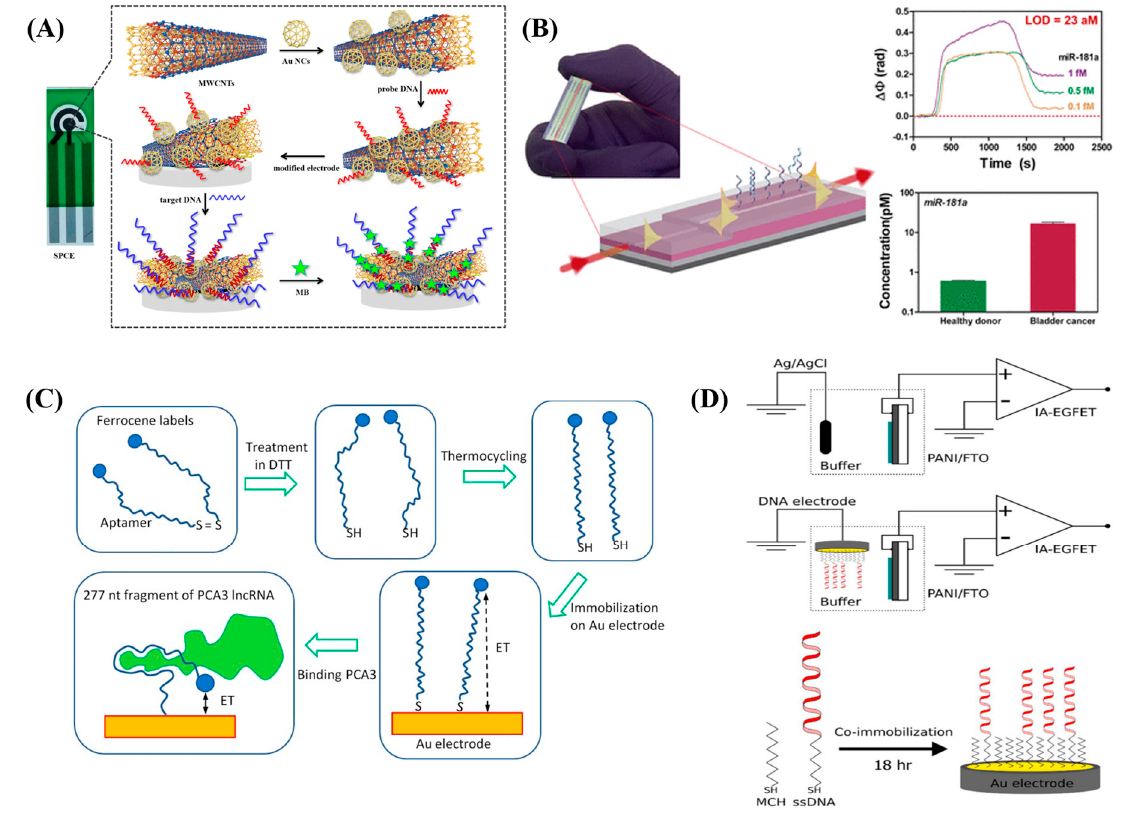
Figure 5. ( A ) Schematic representation of the SPCE electrochemical DNA biosensor. Re-used with permission from Ref.[50]. ( B ) Design and working principle of a BiMW sensor chipRe-used with permission from Ref. [51]. (Copyright 2022 American Chemical Society) ( C ) step–by–step design of aptasensor. Re-used with permission from Ref. [52] and ( D ) schematic representation of a potentiometric IA-EGFET sensor. Re-used with permission from Ref. [53]. (Copyright, 2021 Elsevier, reproduced with permission from Elsevier Ltd.).